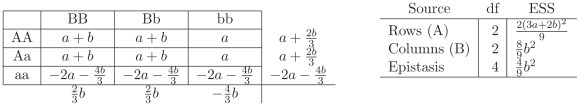
Punnett Square, Factors and Expected Sums of Squares for epistasis case c (
Fig. 1c
).